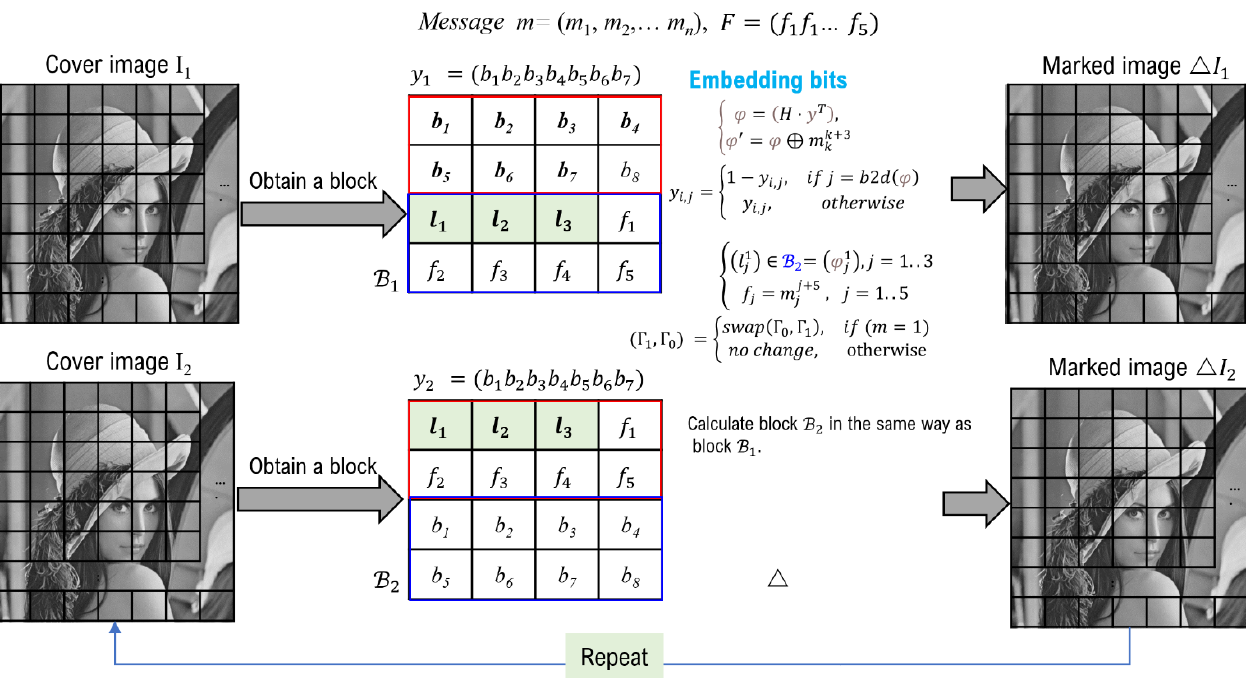
Figure 3. Diagram of embedding